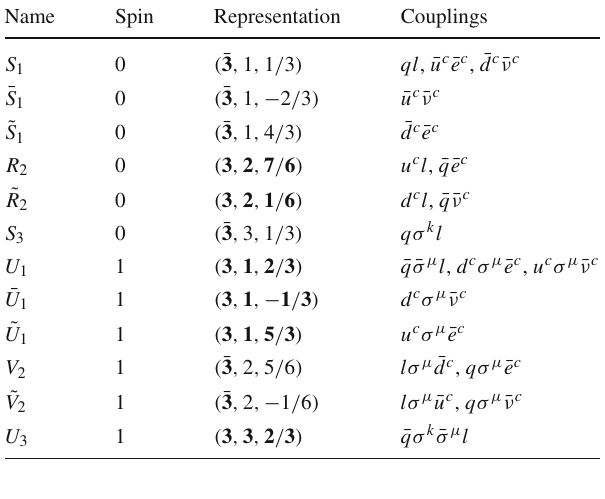
Table 3 Complete list of scalar and vector leptoquarks that can have tri-linear couplings to a quark and a lepton. The nomenclature follows the one used in Refs.